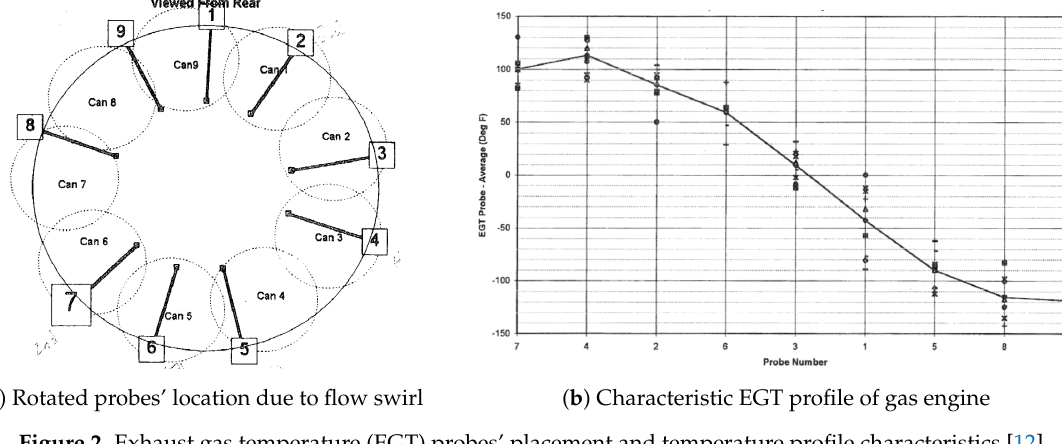
Figure 2. Exhaust gas temperature (EGT) probes’ placement and temperature profile characteristics